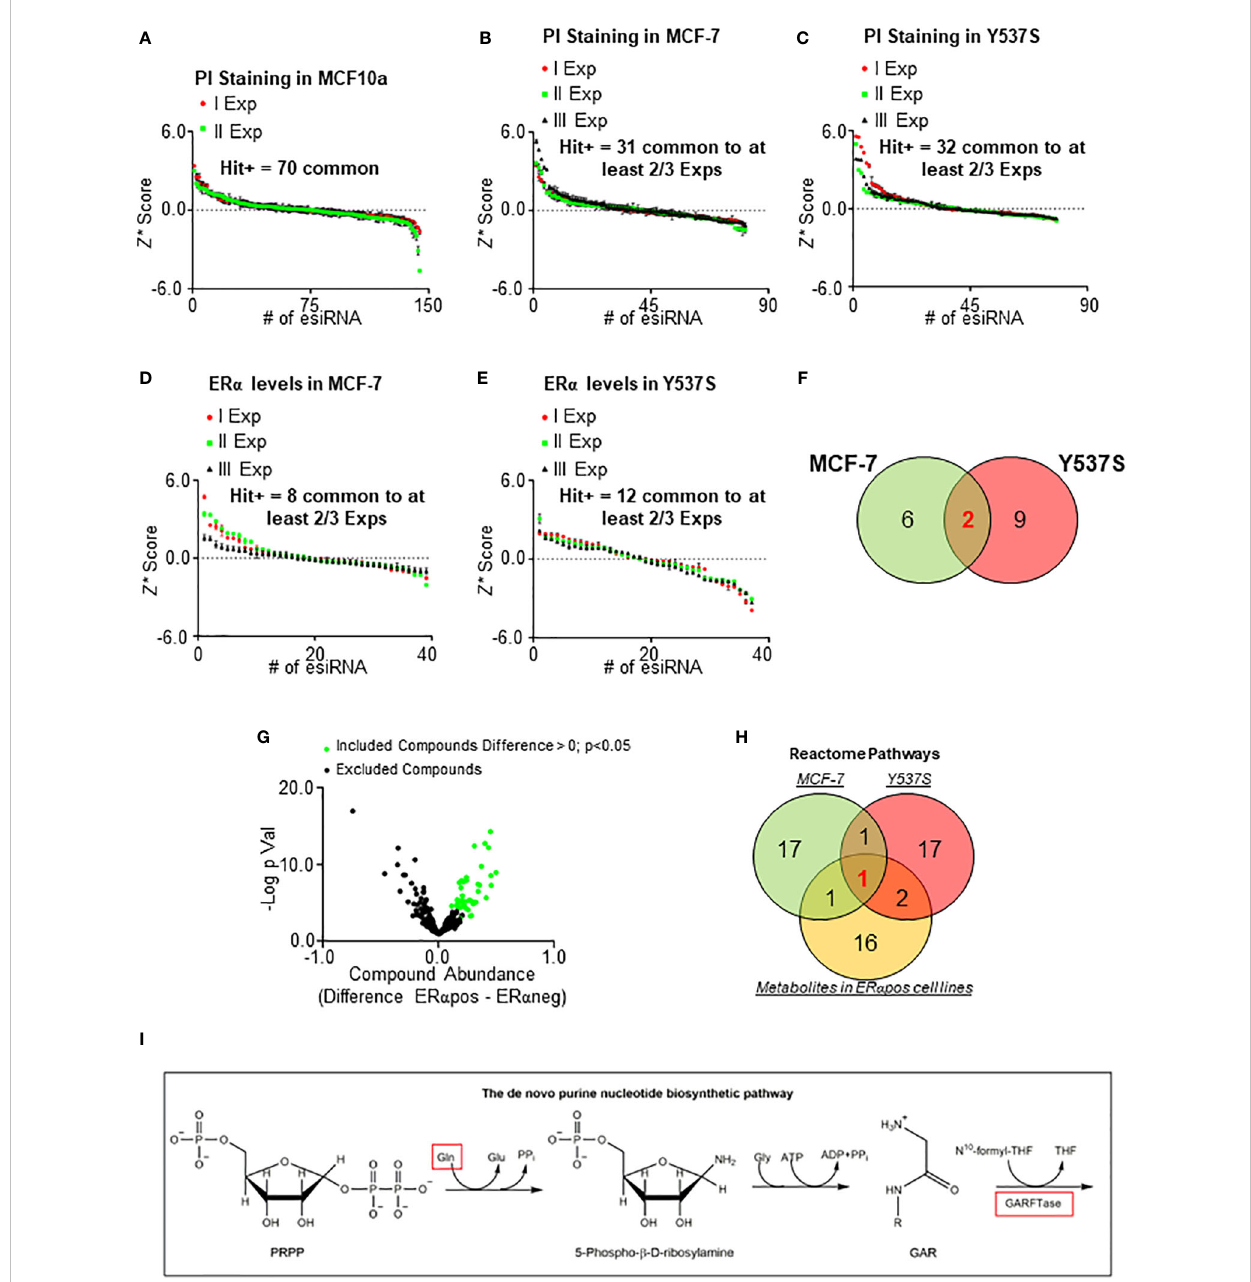
FIGURE 1 Identi fi cation of metabolic pathway in fl uencing ER a levels and cell proliferation in primary and metastatic breast cancer cells. Robust Z scores ( Z* ) graphs for siRNA oligonucleotides (esiRNA)-treated samples for 48 hours in MCF10a (A) , MCF-7 (B, D) , and Y537S (C, E) cells. The ER a levels were detected by in-cell WB (D, E) while cell number was detected by in-cell propidium iodide (PI) staining (A, B, C) . (F) Venn diagrams showing the positive hits for ER a and PI lists in MCF-7 and Y537S cells. (G) Volcano plot showing the differences in metabolic compounds among ER a -positive and ER a -negative BC cell lines. Data have been downloaded by the DepMap portal (https://depmap.org/portal). Green dots represent the compound considered as signi fi cant according to the thresholds indicated in the fi gure. (H) Venn diagram showing pathway enrichment as extrapolated by the Reactome (https://reactome.org/PathwayBrowser/#/) database for positive hits in either MCF-7 and Y537S cells or metabolites in ER a -positive BC cell lines. (I) Schematic showing the initial reaction of the de novo purine biosynthetic pathway. Red squares indicate the up- regulated compound in ER a -positive BC cell lines and the enzyme found in both MCF-7 and Y537S